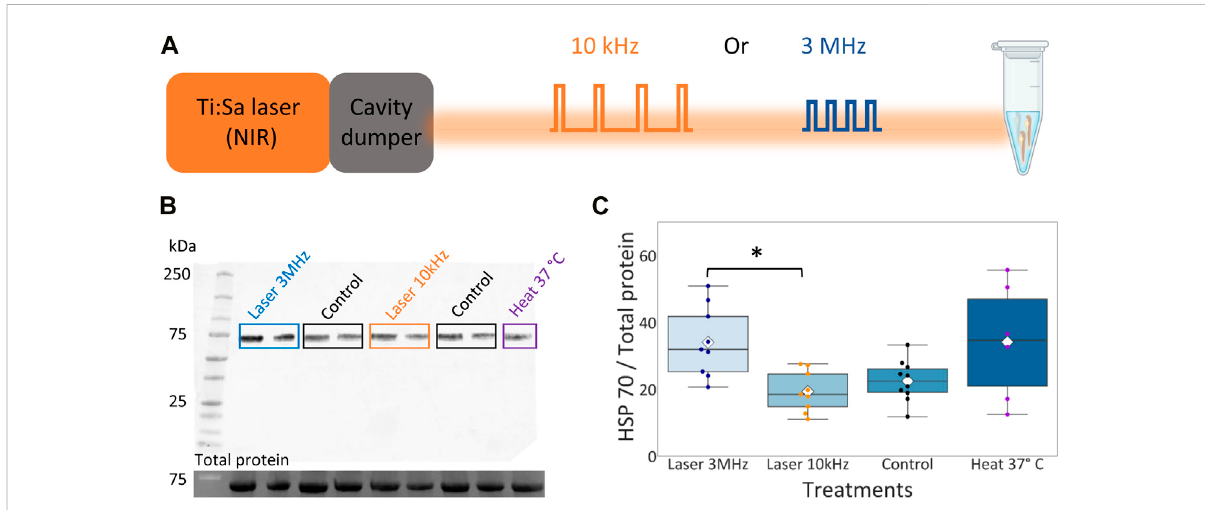
FIGURE 5 Hsp70 expression level in zebra fi sh embryos upon NIR illumination. (A) Layout of zebra fi sh embryos NIR radiation at different repetition rates. Eppendorf image created with BioRender.com. (B) Top: Representative western blot of whole protein extracted from 72 hpf zebra fi sh embryos probed with anti-Hsp70 antibody. Bottom: Corresponding stain-free western blot showing the total protein molecular weight. (C) Box plot for the quanti fi cation oftheratio between theexpressionlevel ofHsp70 and thetotalamount ofprotein.Rhombuses:average values; horizontalblack lines: median values; scatter plot: data points in each group with different color code. Groups labeled with star symbols are signi fi cantly different (Kruskal – Wallis test, p = 0.02, post-hoc Mann-Whitney test with Bonferroni correction, p =